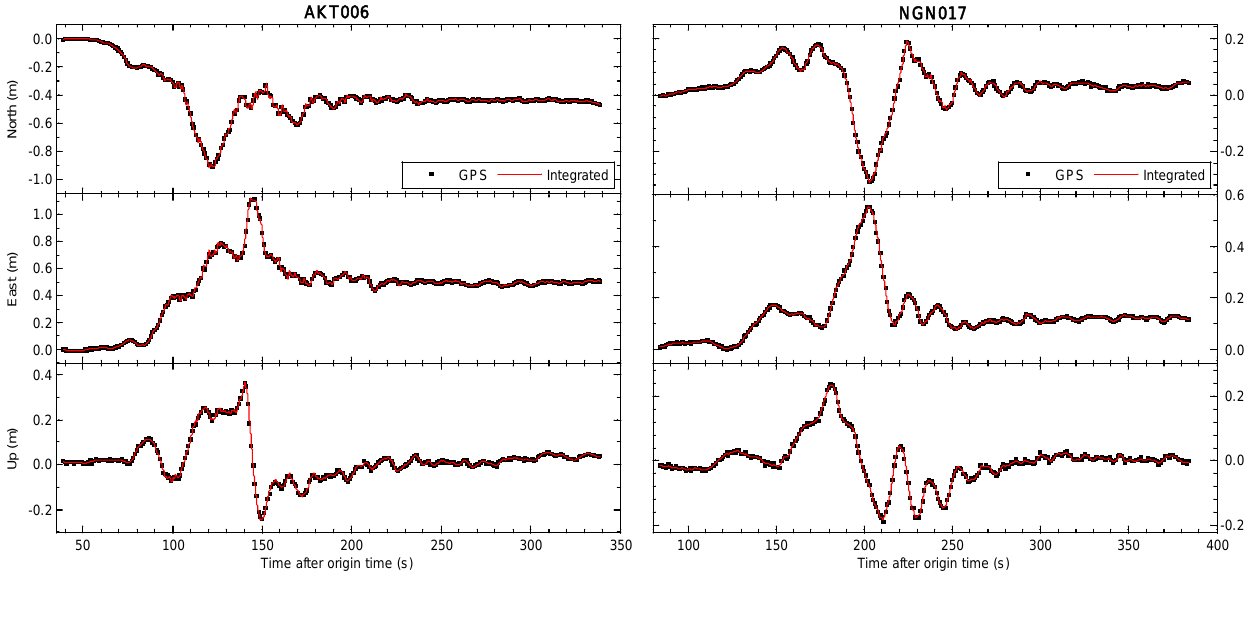
Figure 2. Comparison of GPS-only and tightly-integrated displacements on the collocated AKT006 (seismic) and 0183 (GPS) pair and NGN017 (seismic) and 0986 (GPS) pair during the Tohoku-oki earthquake on 11 March 2011. The sub-figures show from top to bottom the entire period of seismic shaking in north, east and up components